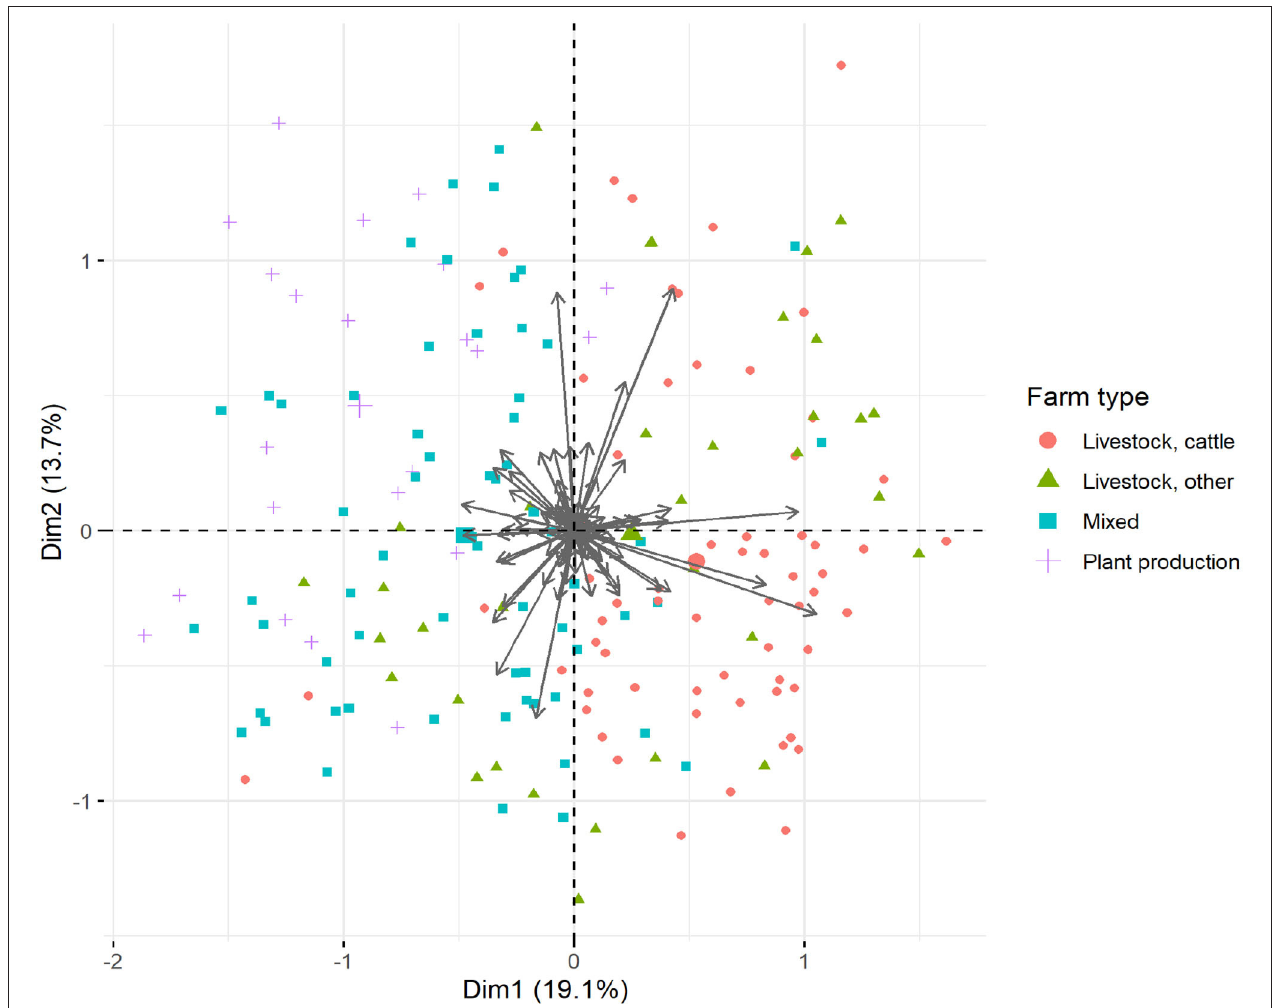
FIGURE 2 | Robust PCA biplot of farms (symbols) and indicators (arrows). The plot shows farms largely grouping by farm type (left and right side of Dim2). Several indicators also align with the direction and magnitude of the first two dimensions (longer arrows aligned with the axes that break from the group at the center of the